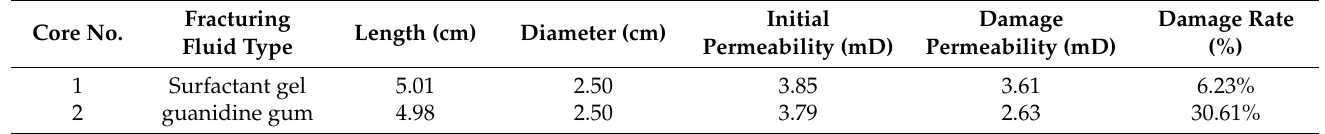
Table 2. Evaluation of core damage performance of the fracturing fluid